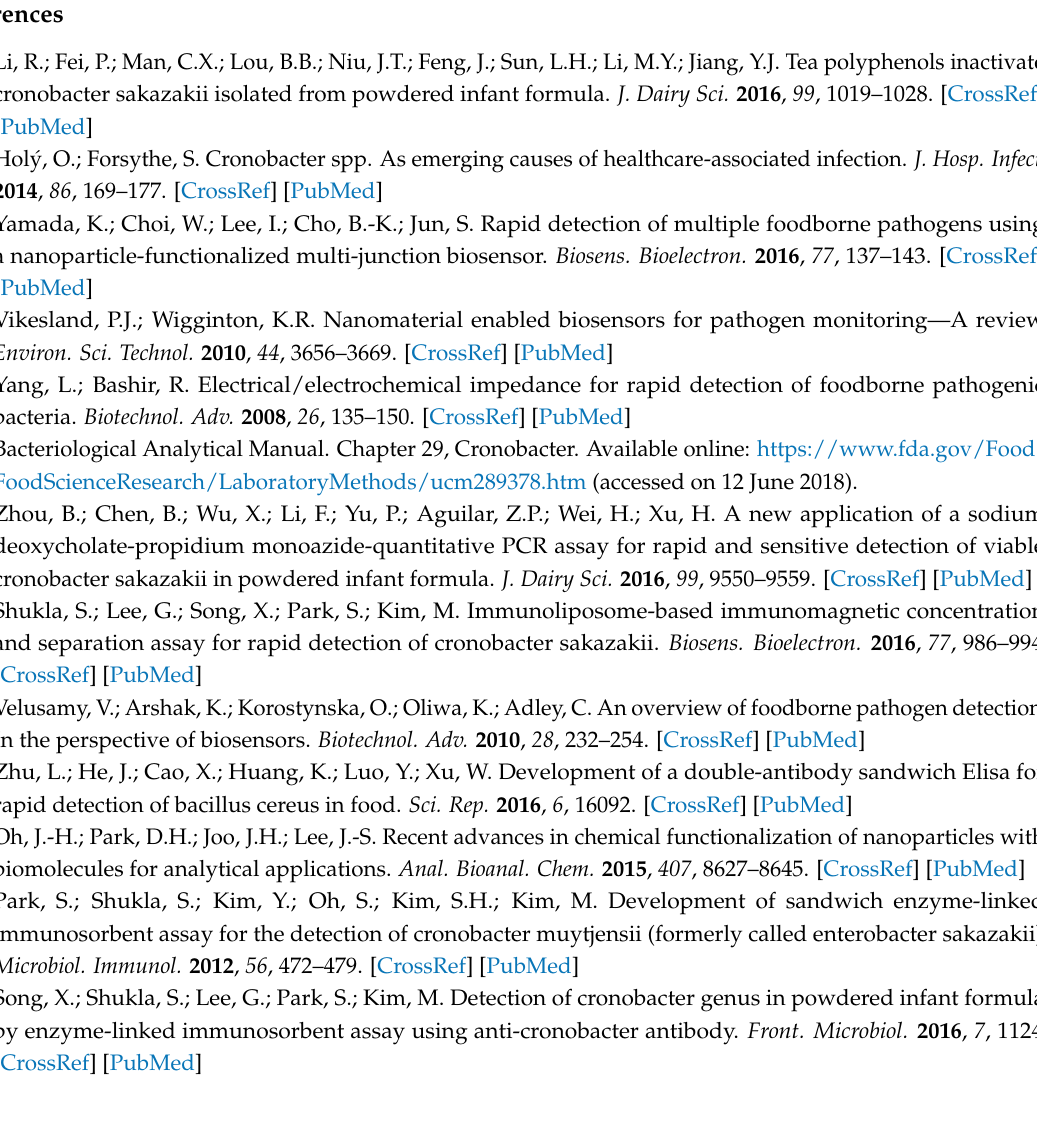
s1, Detailed protocols and additional data and results. Figure S1: SDS-PAGE of purified anti- C. sakazakii IgG, Figure S2: Western blot of whole bacterial cell material of C. sakazakii , Figure S3: DLS size distributions fo differentl functionalized Au nanoparticles, Figure S4: TGA curve of weight loss upon heating the Au nanoparticles functionalized with HS-PEG-biotin 100%, Figure S5: UV-Vis extinction spectroscopy of differently functionalized Au nanoparticles, Figure S6: UV-Vis extinction spectra of bacteria samples of C. sakazakii incubated with PEG-grafted Au nanoparticles and then separated from free Au nanoparticles, Figure S7: Bacteria targeting by Au nanoparticles, Table S1: Zeta Potential determination of gold nanoparticles, Table S2: Zeta potential determination of gold